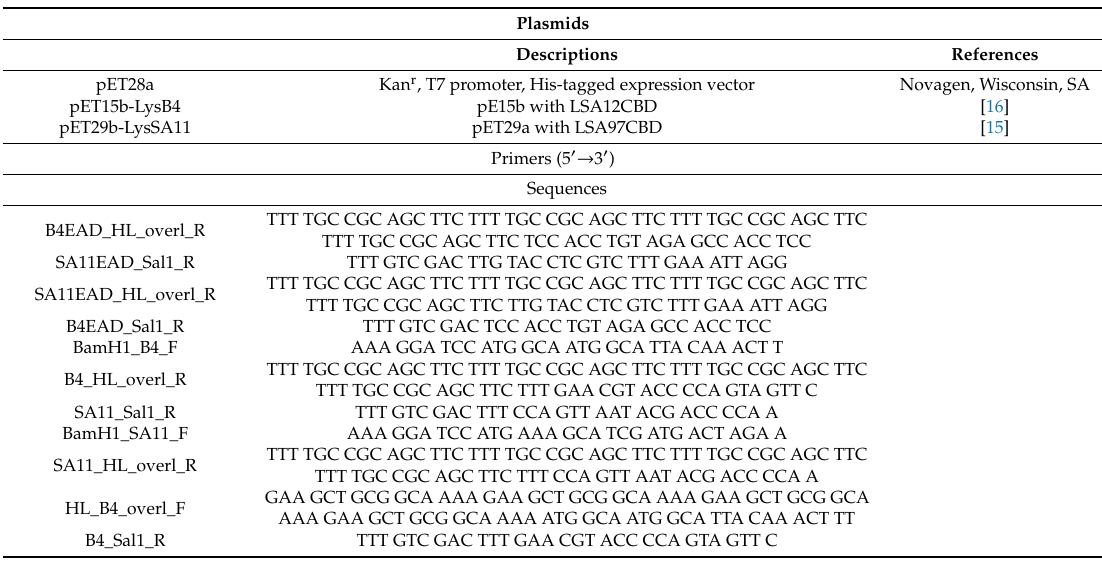
Table 2. Plasmids and primers used in this